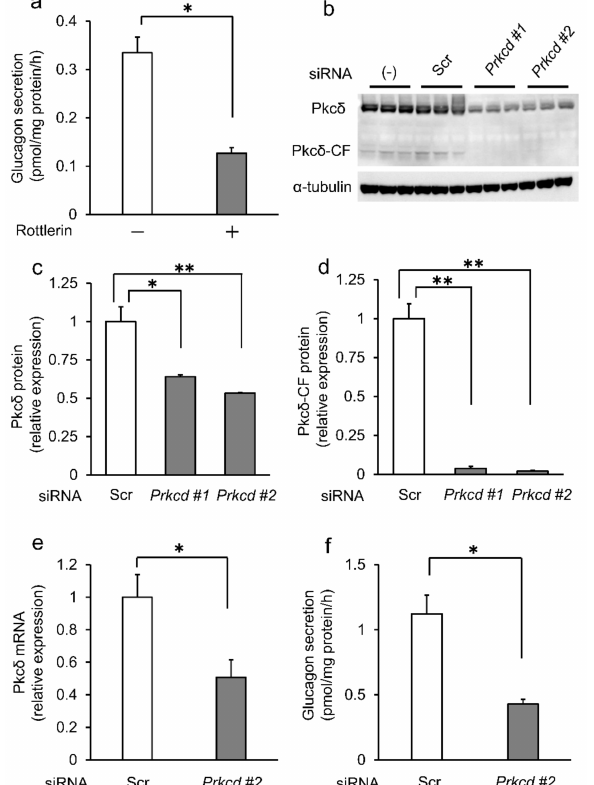
Figure 1. Knockdown of Pkc δ decreased glucagon secretion from InR1G9 cells. ( a ) Glucagon secretion was significantly reduced by 10- µ M Pkc δ inhibitor rottlerin in InR1G9 cells. ( b – d ) InR1G9 cells were transfected with scrambled siRNA, Prkcd #1 siRNA, or Prkcd #2 siRNA for 48 h. Cell lysates were examined for Pkc δ and Pkc δ -CF expression by Western blotting. α -tubulin was employed as an internal control. Pkc δ expressions were reduced by around 40–50% Prkcd #1 siRNA and Prkcd #2 siRNA compared to the scrambled siRNA in InR1G9 cells. Pkc δ -CF expressions were also reduced by Prkcd #1 siRNA and Prkcd #2 siRNA in InR1G9 cells. ( e ) Pkc δ mRNA expression was significantly reduced by Prkcd #2 siRNA in InR1G9 cells. ( f ) Glucagon secretion was significantly reduced by Prkcd #2 siRNA in InR1G9 cells. We performed triplicate and three independent experiments. * p < 0.05, ** p < 0.01; t -test ( a , e , f ) or ANOVA (Bonferroni adjustment) ( c , d ). Data are expressed as means ±